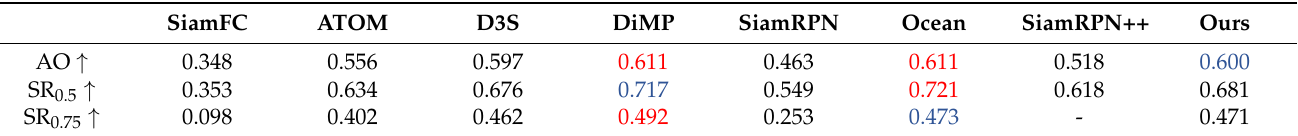
Table 4. Comparison of properties on the public GOT-10K test dataset. Red and blue represent 1st and 2nd, respectively.